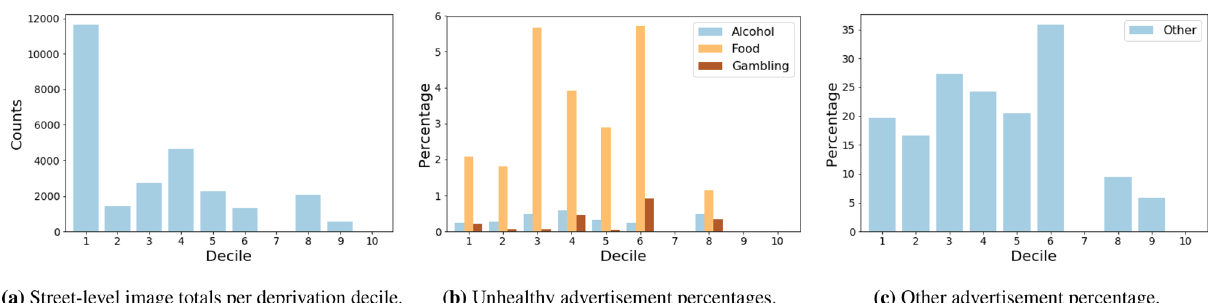
Figure 4. ( a ) Illustrates the number of street-level images per deprivation decile according to the 2019 English indices of deprivation. ( b , c ) Contain the percentage of images with unhealthy advertisements and those of type ‘other’